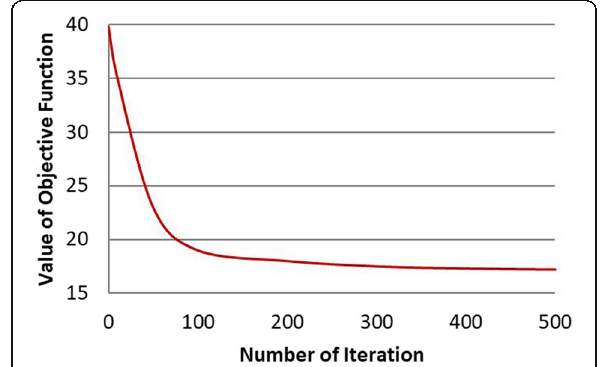
Fig. 4 Convergence of the objective function on Refined-MORPH